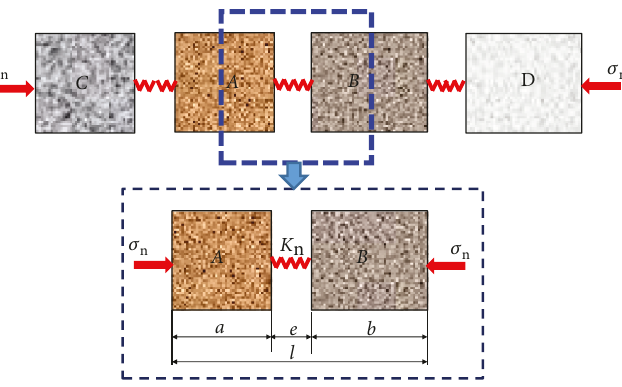
Figure 9: Equivalent continuum model of heterogeneous rock mass with single fi